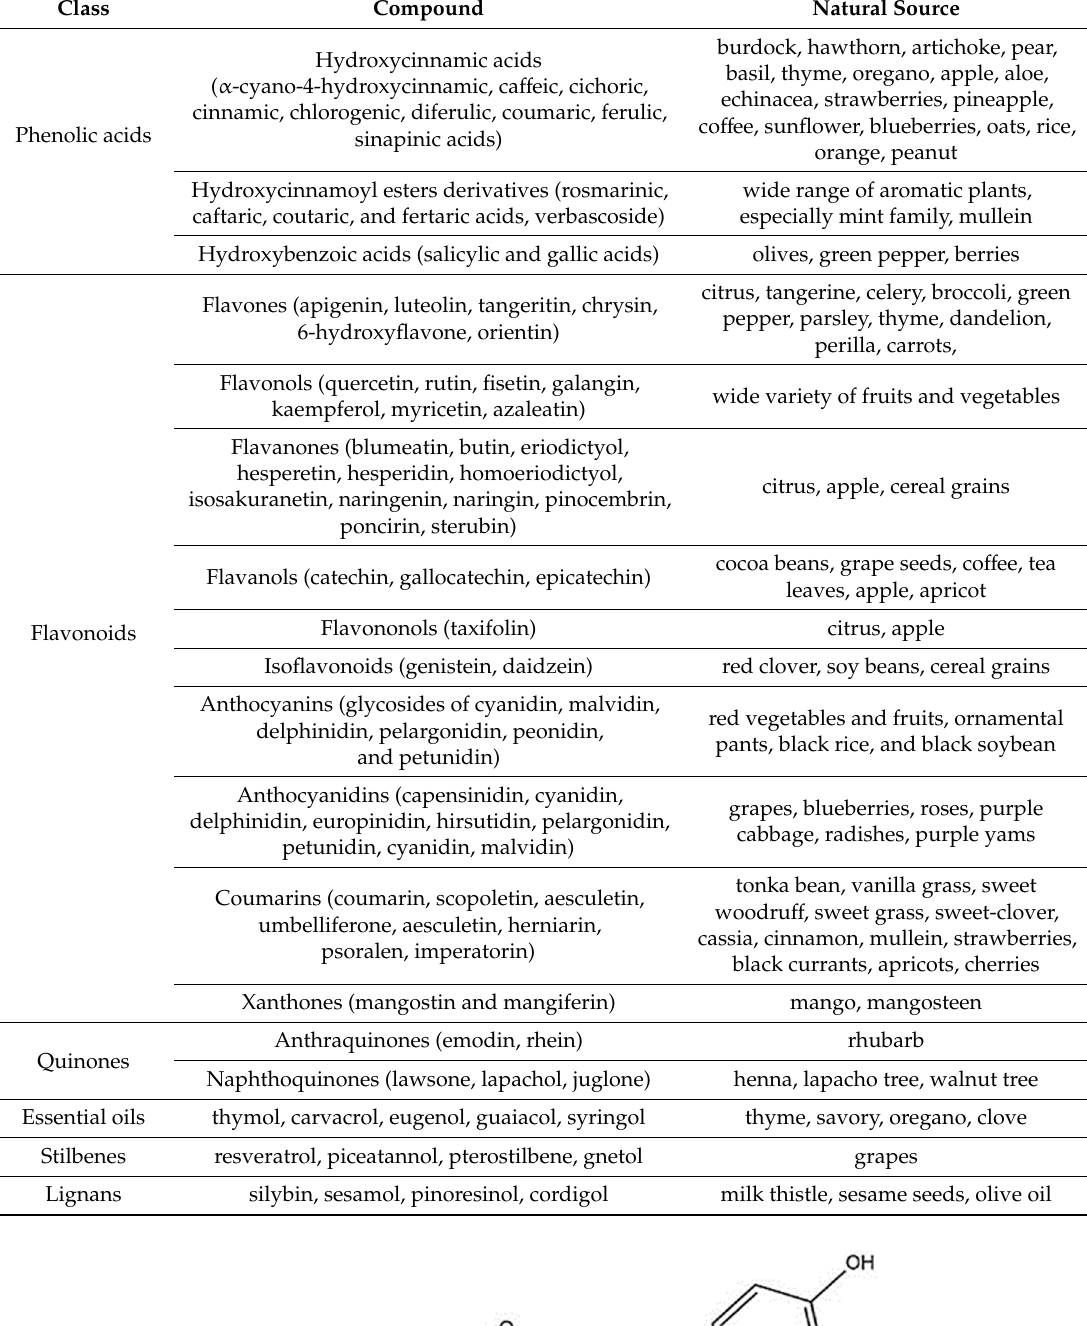
Table 1. The most important classes of phenolic compounds reported in plant materials.